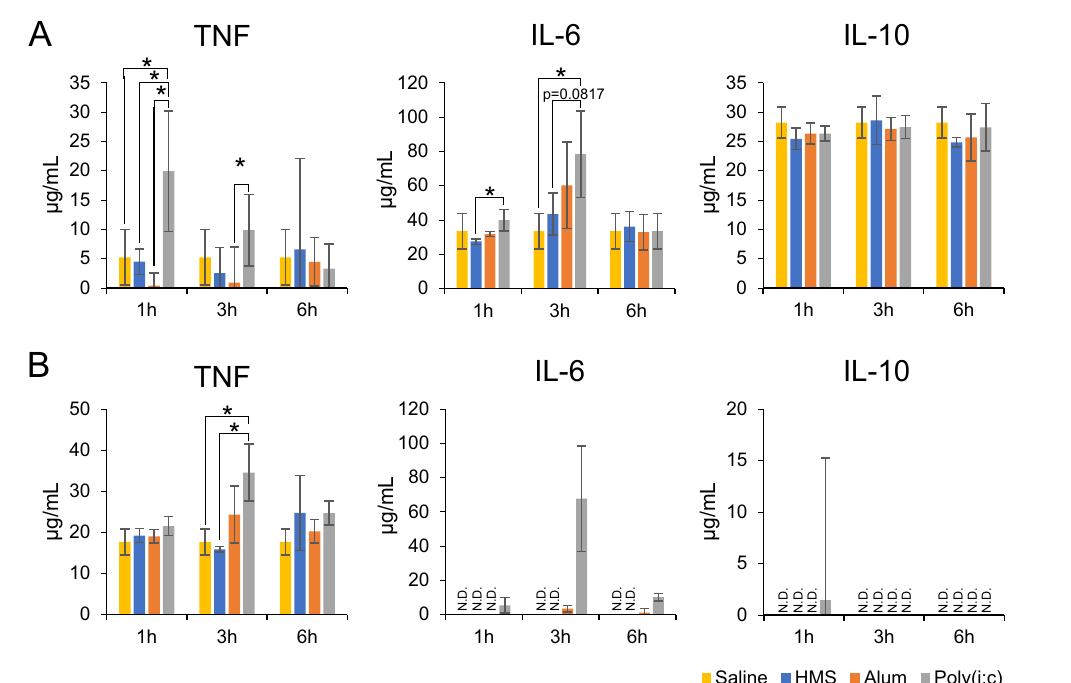
Fig. 5 Cytokine induction of the mice administered with HMS particles, Alum, or polyinosinic-polycytidylic acid (Poly(i:c)). A Intraperitoneal administration. B Subcutaneous administration. * p < 0.05 Student ’ s t test. Saline administered group was as the negative